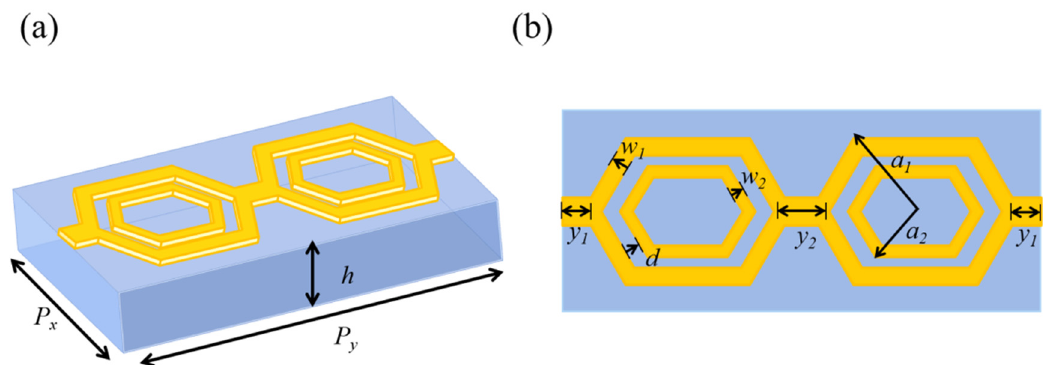
Figure 4. Schematic diagram of nested double-hexagon ring-shaped structure unit ( a ) Structural stereogram; ( b ) Top view of the structure.